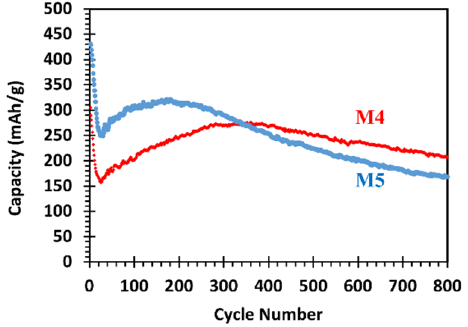
Figure 5. A comparison in the specific capacity as a function of cycle numbers between M4 and M5 cells. Both of them are made of Si@void@C powder without particle classification. The UCV of M4 is 1.0 V vs. Li + /Li, whereas the UCV of M5 is 1.5 V. See Table 1 for more details.